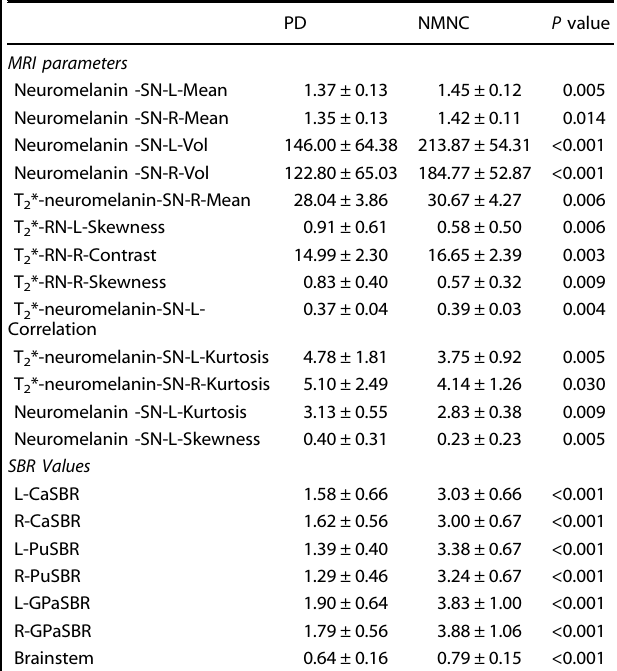
SBR, GPaSBR Globus pallidum